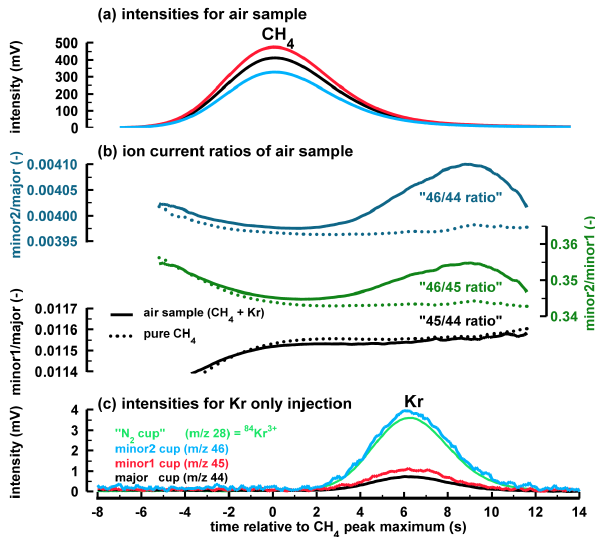
Fig. 4. Comparison of a CH 4 peak of an air sample with the signals gained from an injection of pure Kr measured with the Bern system at CO 2 focusing. (a) Beam intensities in mV for the CH 4 sample peak (369ppb CH 4 with natural abundance of Kr) with the retention time centred to the CH 4 peak maximum. (b) Background-corrected ion current ratios (“46/44 ratio” in blue, “46/45 ratio” in green and “45/44 ratio” in black) of the atmospheric air sample (solid line) and pure CH 4 (dotted line), illustrating the anomalies seen in “46/44” and “46/45” but with no visible effect on “45/44”. Panel (c) shows the beam intensities for a measurement where Kr was injected into the GC flow. Due to the chromatographic effect of the GC column, the retention time of the Kr peak is ca. 6s longer than the CH 4 peak, yet there is a considerable overlap. Note the signal measured at m/z 28 (“N 2 cup”) can be directly related to 84 Kr 3 + , which has the exact value of m/z =